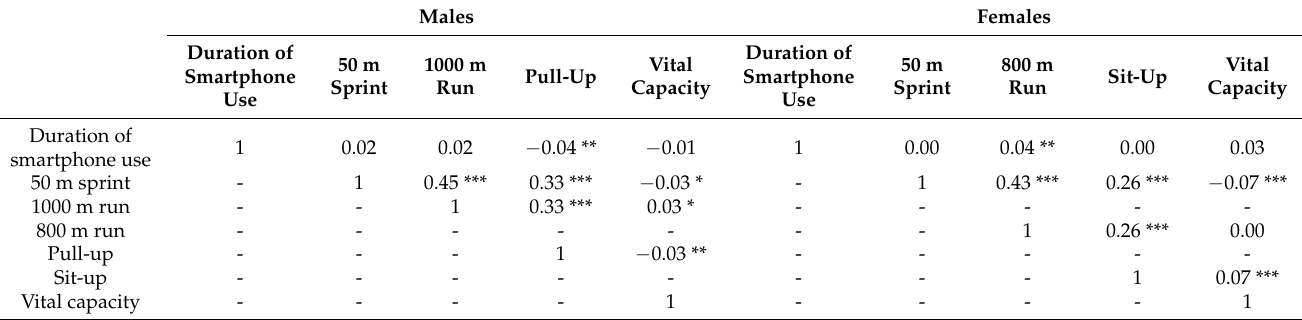
Table 2. Zero-order correlations between each physical fitness test.